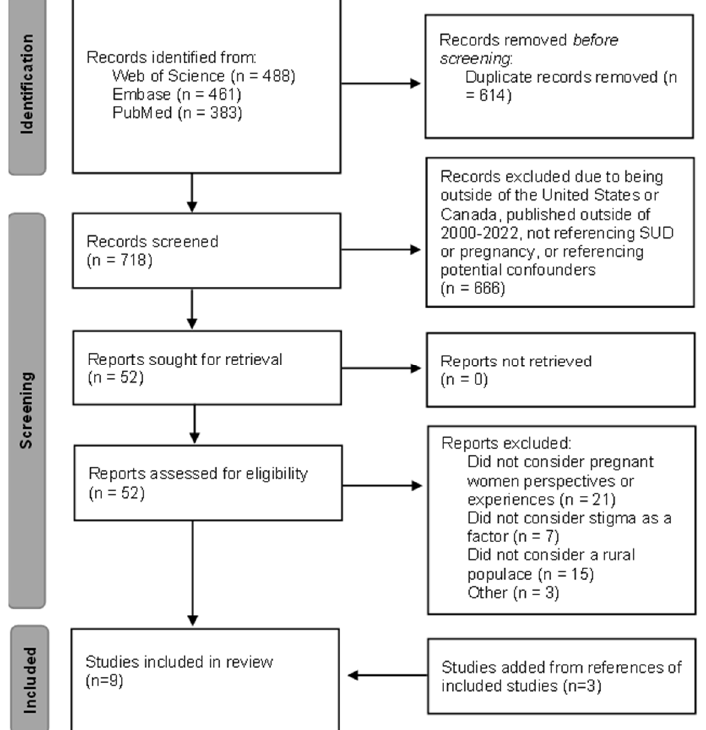
Figure 1. Stepwise literature review. Flow chart adapted from the Preferred Reporting Items for Systematic Reviews [7].